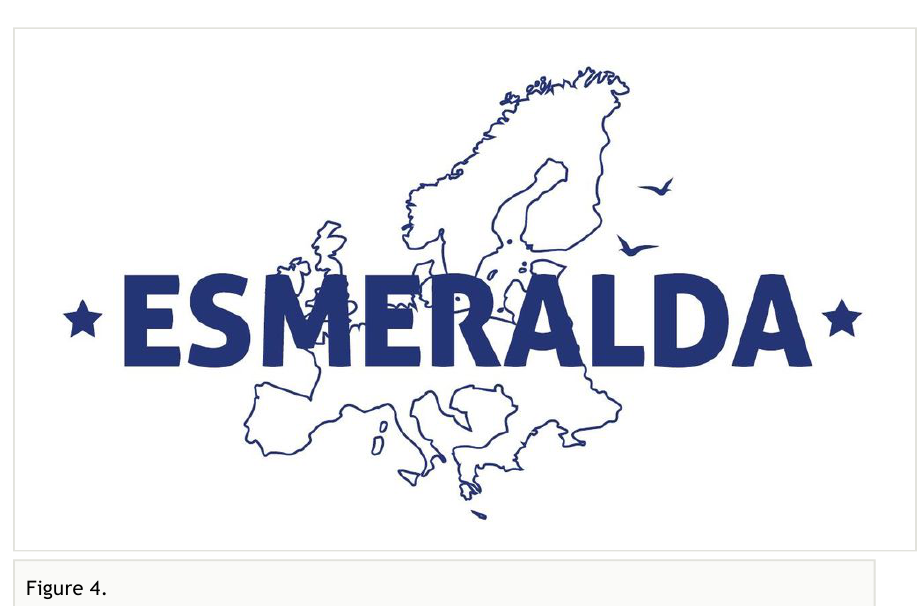
Figure 4. ESMERALDA Logo, bringing together Europe in a generalised